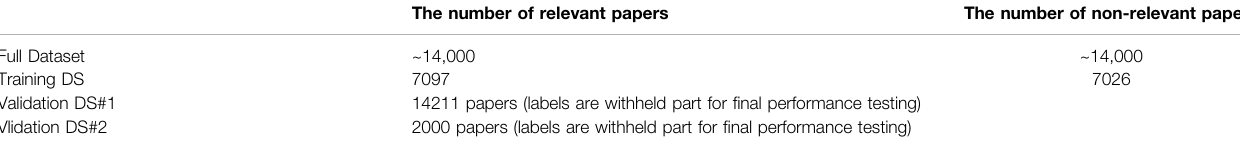
TABLE 2 | Distribution of classes in the dataset